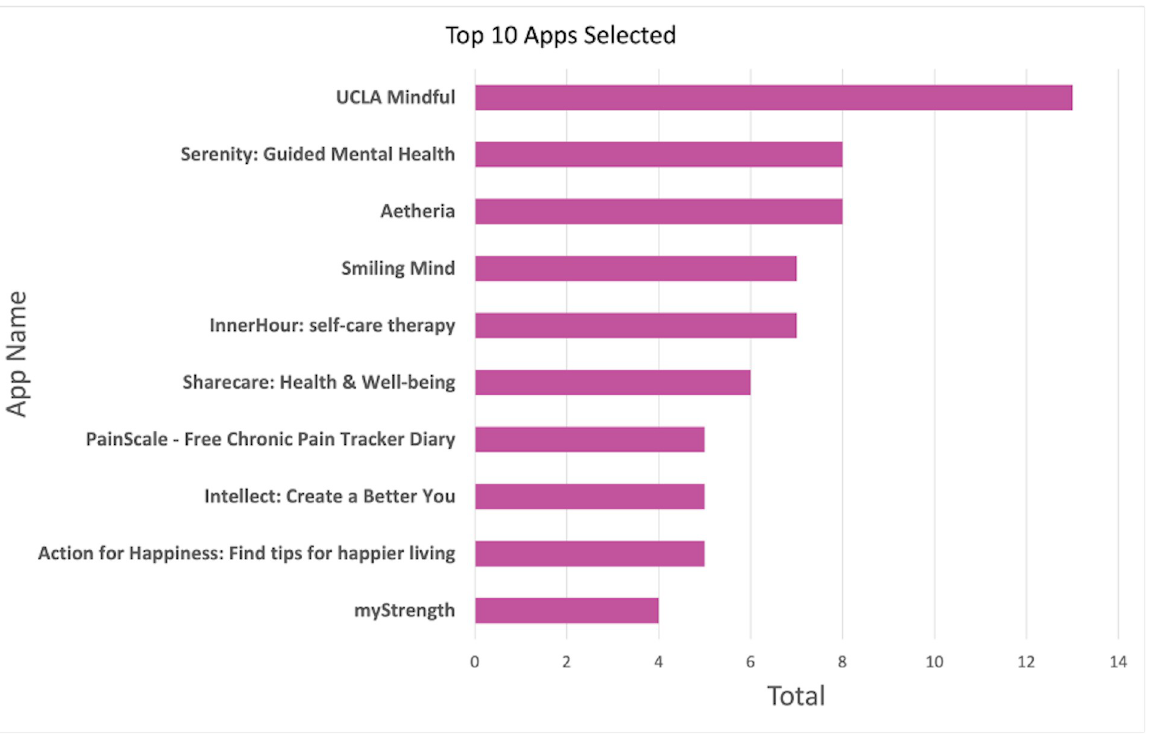
Fig 1. Top ten apps selected by